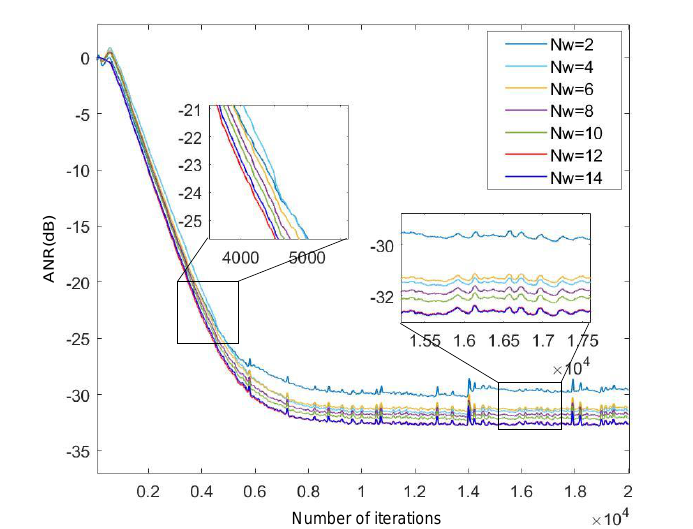
Figure 4. Effect of sliding window size for adaptive strategy.